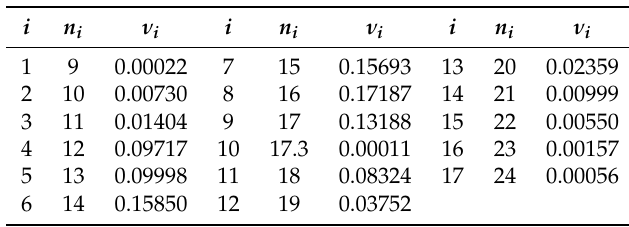
Table 1. Allele (indicated by the number of gene repetition); n i frequencies; v i at the D5S818